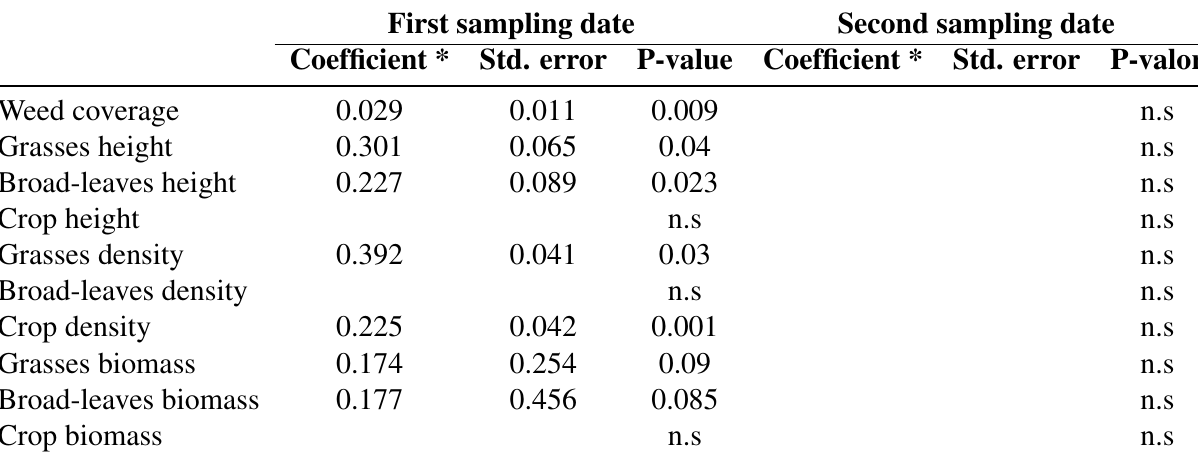
Table 2. Multiple regression analysis between ultrasonic readings and measured coverage, density and biomass for each measured variable (n.s.: not